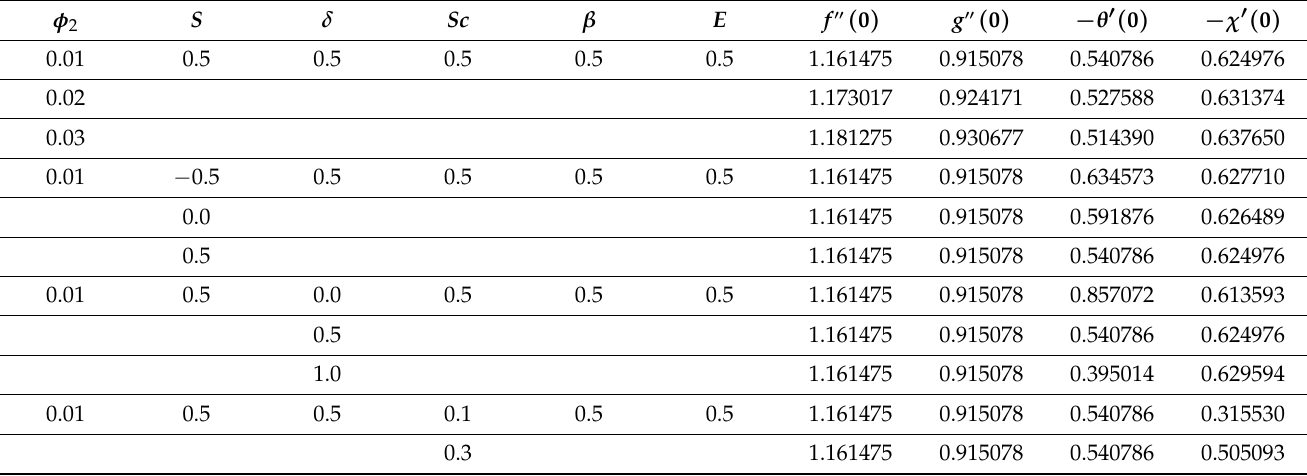
Table 4. For nodal point, computational values of f (cid:48)(cid:48) ( 0 ) , g (cid:48)(cid:48) ( 0 ) , − θ (cid:48) ( 0 ) and − χ (cid:48) ( 0 ) with Pr = 6.2, n = 0.2, α = 0.5 and φ 1 =